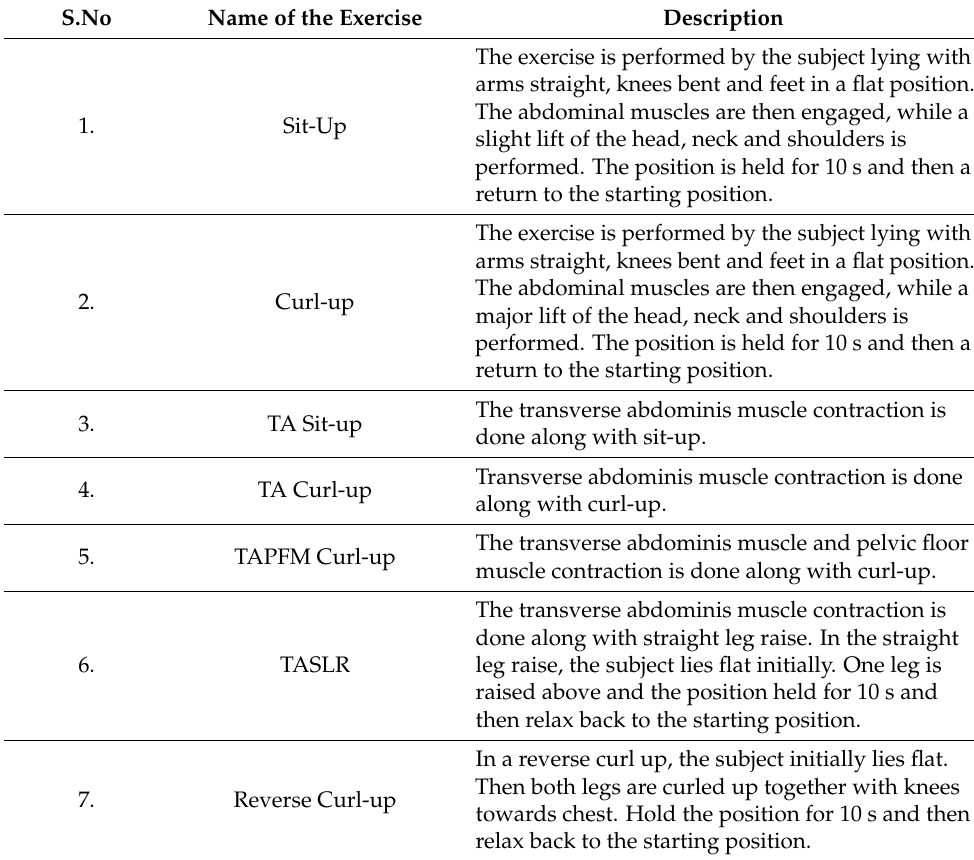
Table 2. Details of abdominal exercises